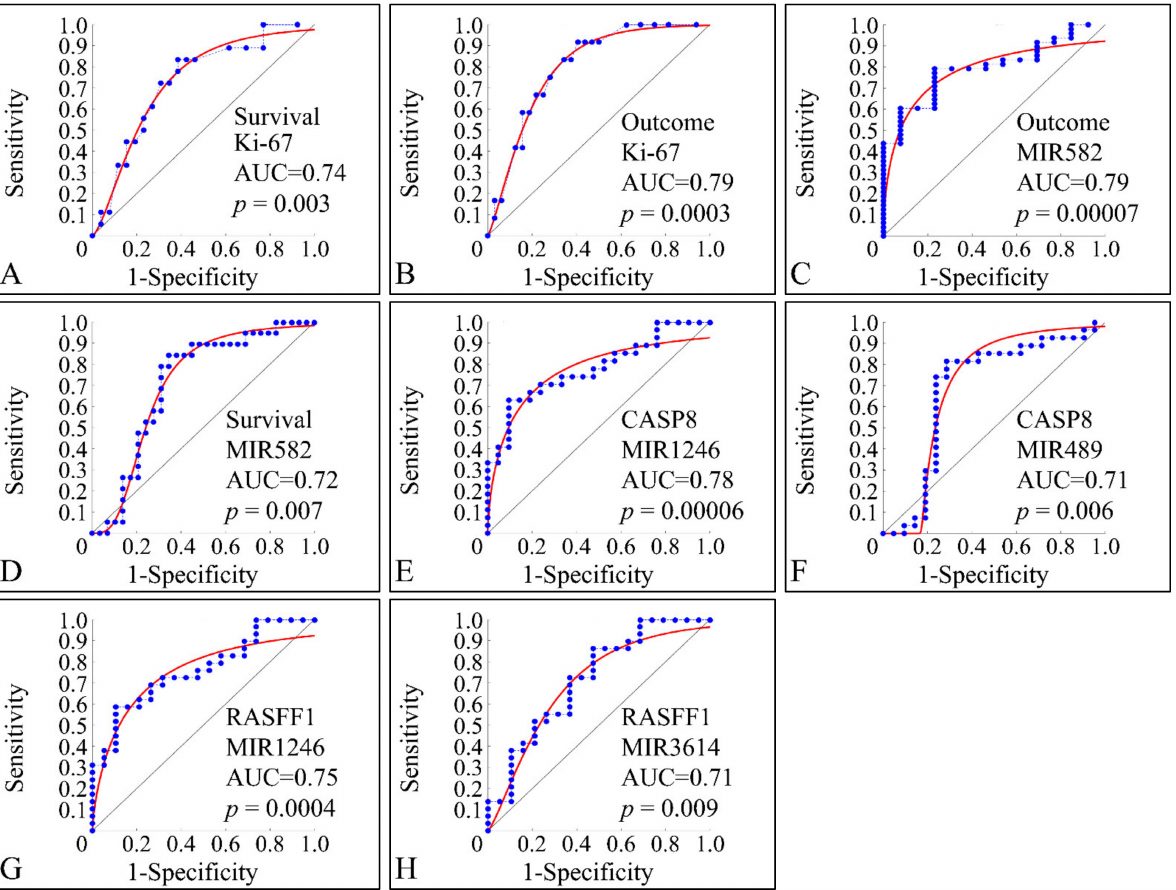
Figure 15. ROC analysis. ROC analysis manifested significant classifiers with respect to clinical parameters. In particular, as expected Ki-67 expression, appeared to classify significantly between alive and deceased patients (described here as survival) ( A ), while it was also able to significantly classify between relapse and clinical remission (described here as outcome) ( B ). Further on, miR-582 appeared to discriminate between clinical remission and relapse ( C ), as well as between alive and deceased patients ( D ). In addition, CASP8 methylation status (i.e., if the gene is methylated or not), was significantly classified by miR-489, while in the case of RASFF1 methylation miR-1246 ( G ) and miR-3614 ( H ) were able to classify between methylated and un-methylated